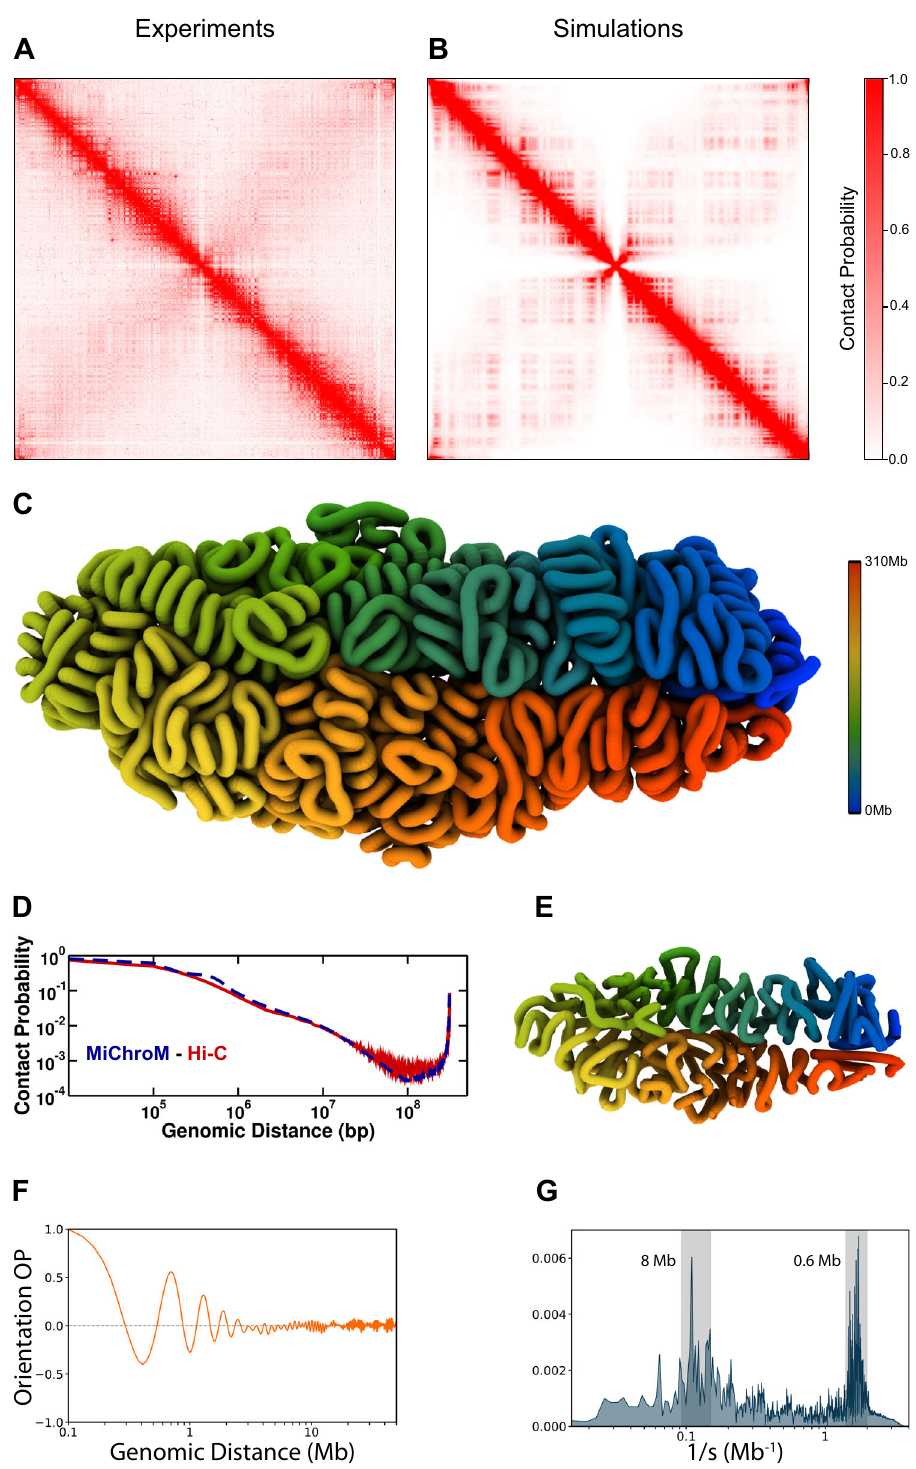
Fig. 1 | Hi-C maps and 3D structures of chromosome 1 after the parameter ’